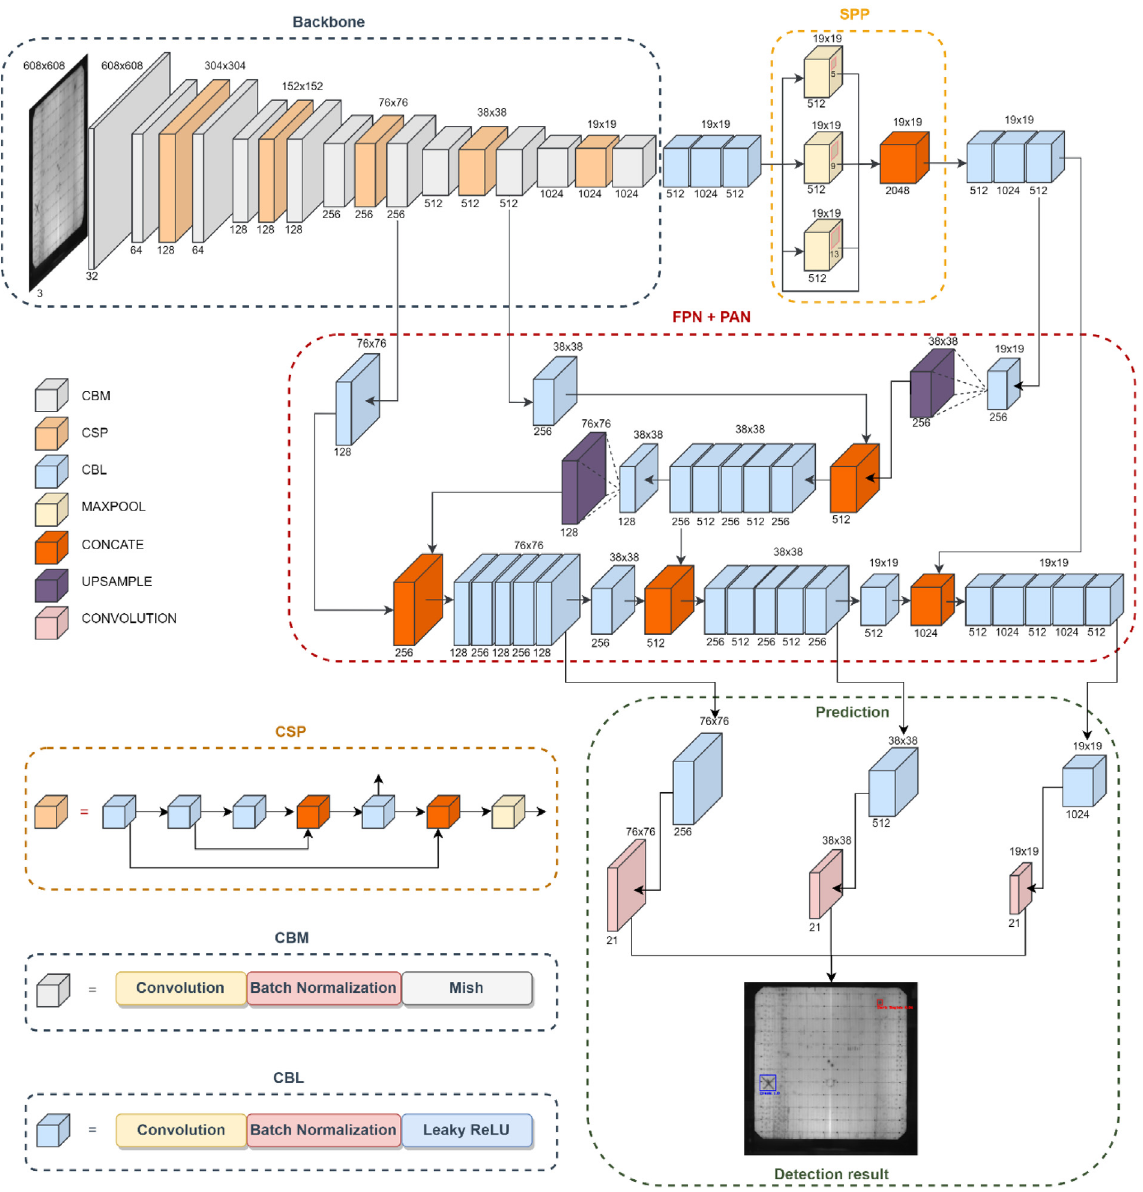
Fig. 3. The architecture of the original heavy-weighted